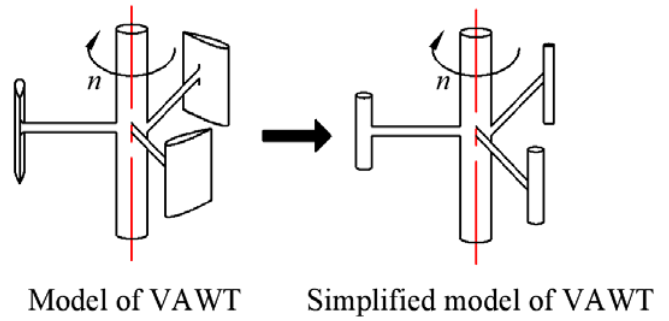
Figure 2. Simplified model of a VAWT.